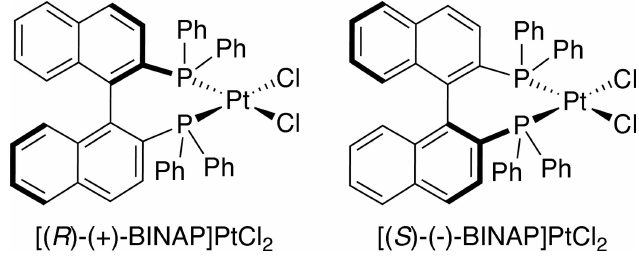
Figure 2 Atropisomers of